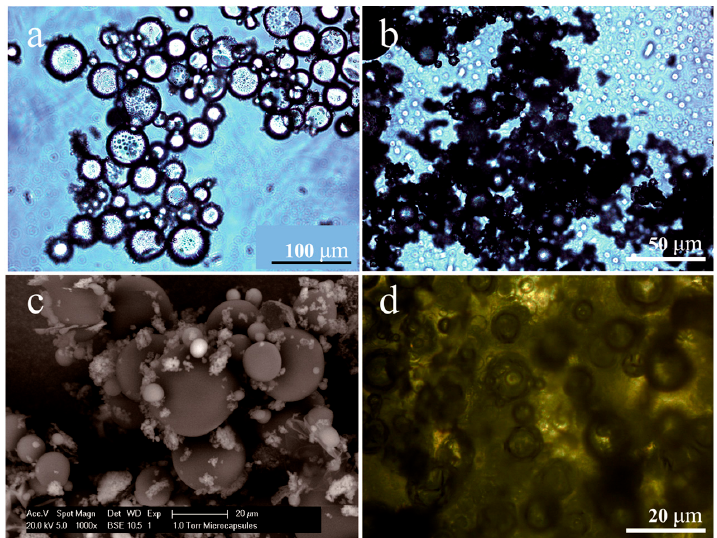
Figure 4. Morphologies of microcapsules and microcapsules/bitumen composite, ( a , b ) optical morphologies of microcapsules; ( c ) ESEM morphologies of microcapsules; ( d ) fluorescence microscope morphology of microcapsules/bitumen composite at 25 ◦